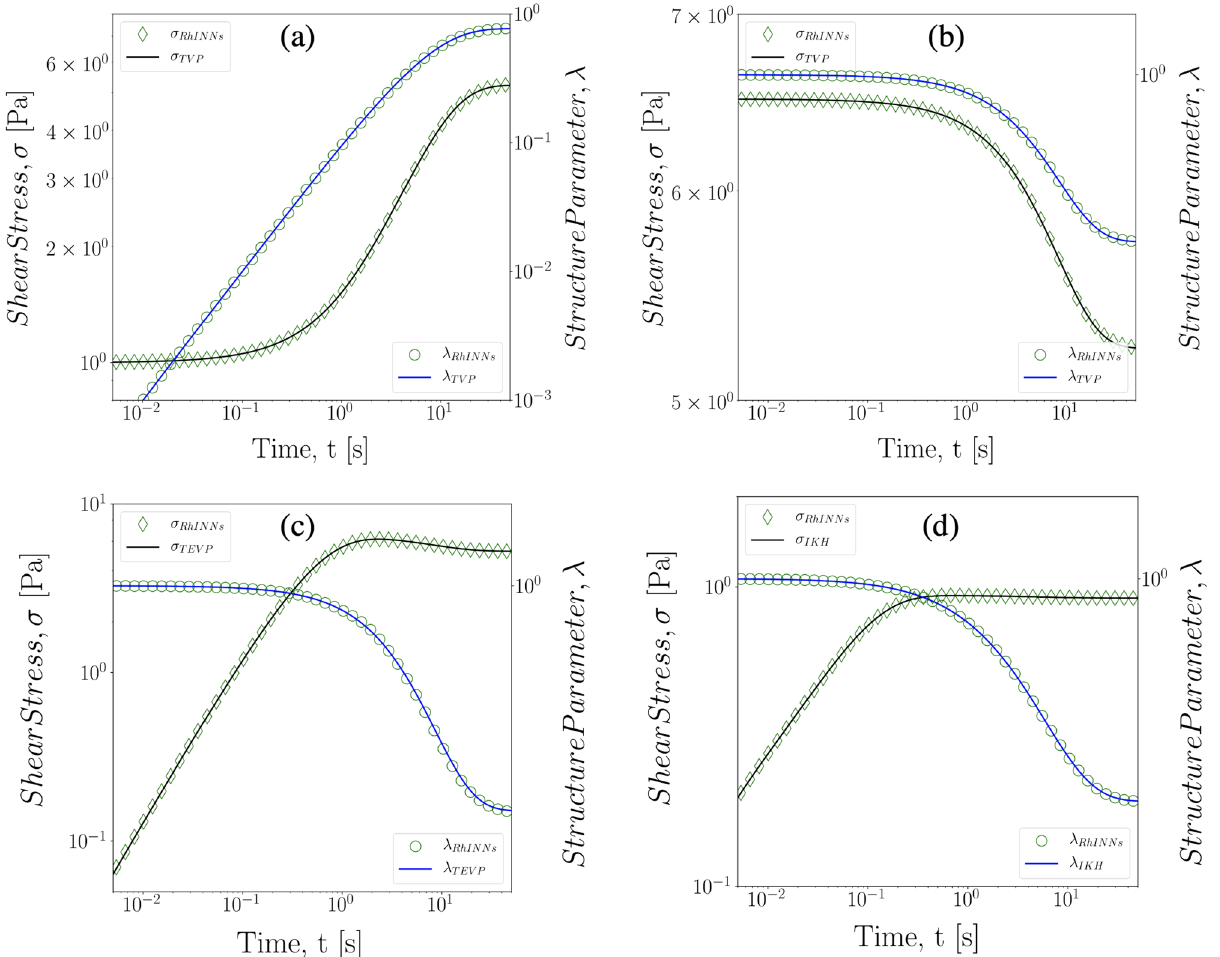
Figure 2. Direct solution of different constitutive models in a shear start-up flow protocol and applied shear rate of 0.1 [ 1 / s ] : (a) Fully fluidized TVP fluid, (b) fully structures TVP fluid , (c) fully fluidized TEVP, and (d) fully fluidized TEVP fluid with IKH model, with parameters based on Table